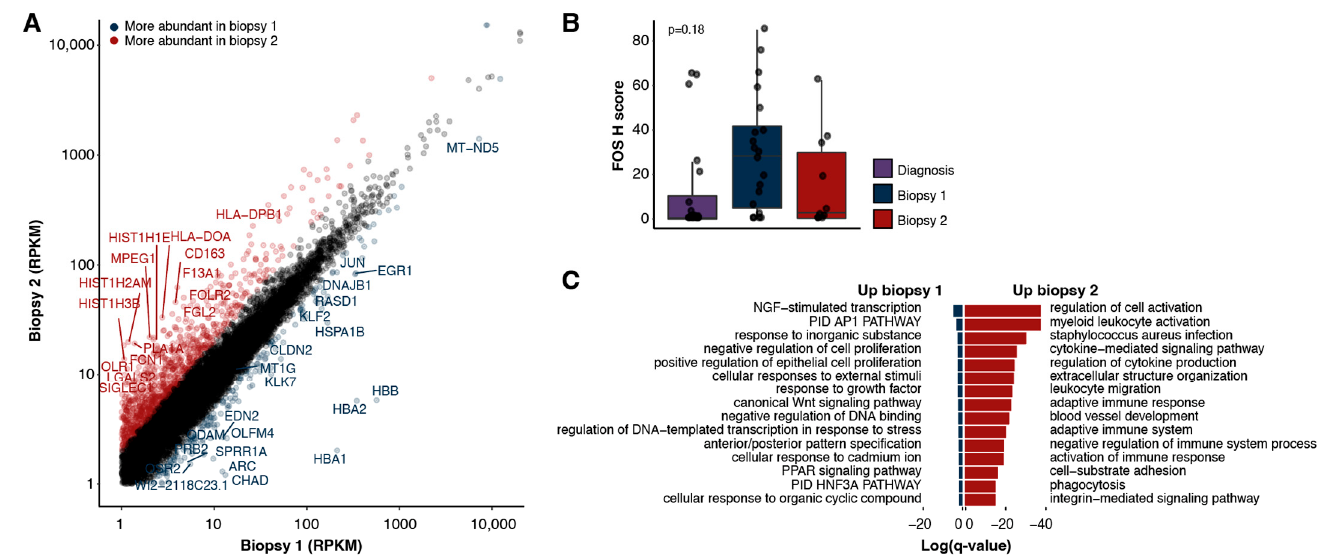
Figure 3. Expression landscapes. ( A ) Expression of protein-coding genes detected in the two biopsies (RPKMs). Genes identified as up-regulated ( ≥ 2-fold) in the second biopsy are indicated in red, and those up-regulated in the first biopsy are in blue ( ≥ 2-fold). ( B ) H score for FOS as measured with immunohistochemistry for biopsies one, two and the earlier diagnostic sample. The p -value is determined with a two-tailed Wilcoxon rank sum test between biopsy one and two. ( C ) Gene ontologies enriched in either the first (left) or second (right) biopsies.